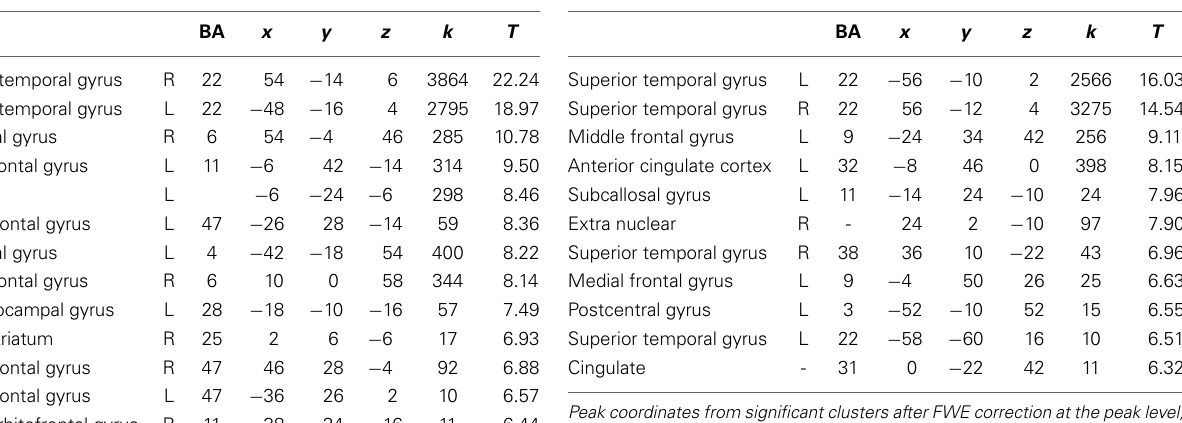
Table 5 | Main effect of happy vs. sad music (FWE p <